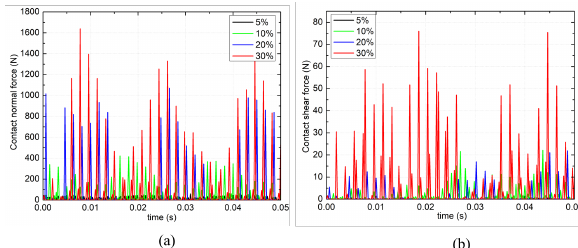
Figure 17: Comparison of a) normal contact force b) contact shear force of debonded